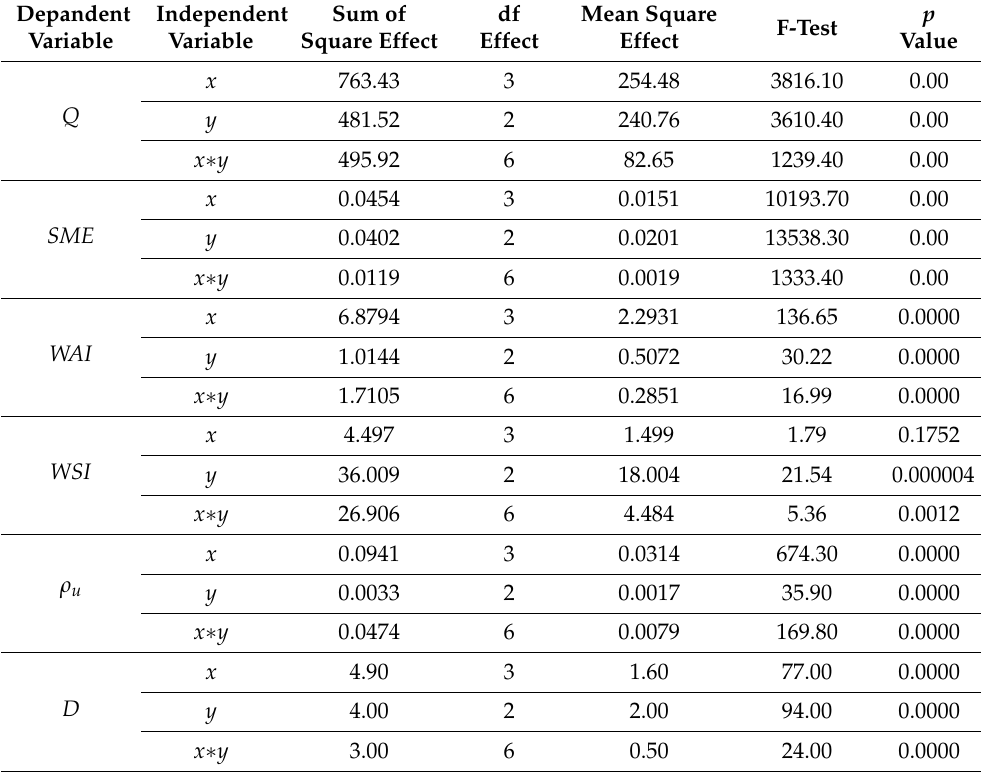
Table 3. Results of the ANOVA of the effects of processing conditions and their interactions on the tested properties of extruded corn